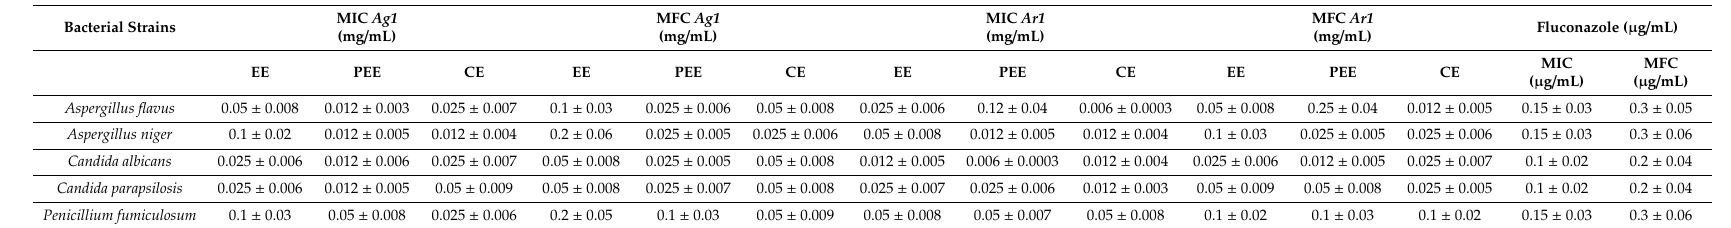
Table 7. Antifungal activity of A. genevensis ( Ag1 ) and A. reptans ( Ar1 ) extracts.